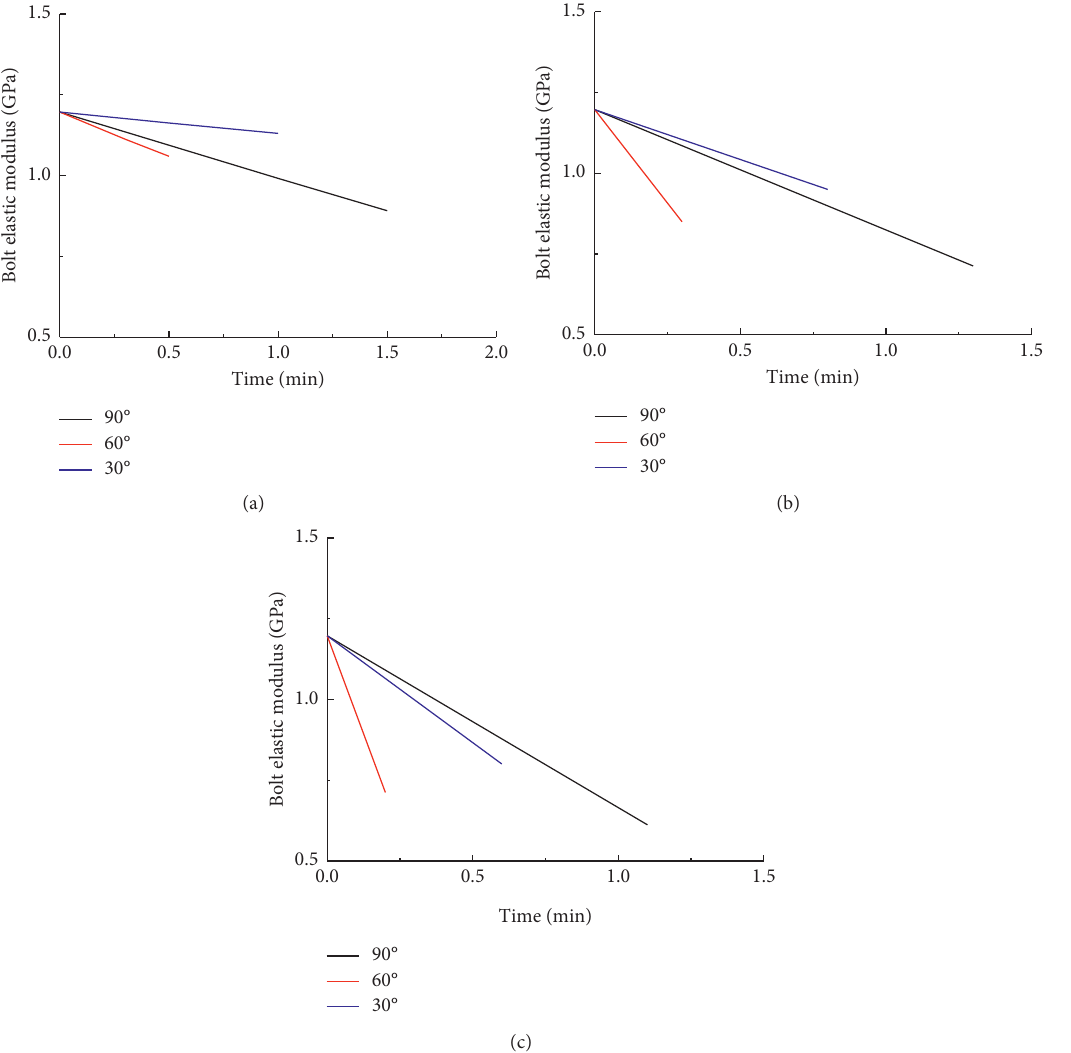
Figure 9: Joint model piece anchor elastic modulus loss curve. (a) The stress is 2MPa. (b) The stress is 4MPa. (c) The stress is